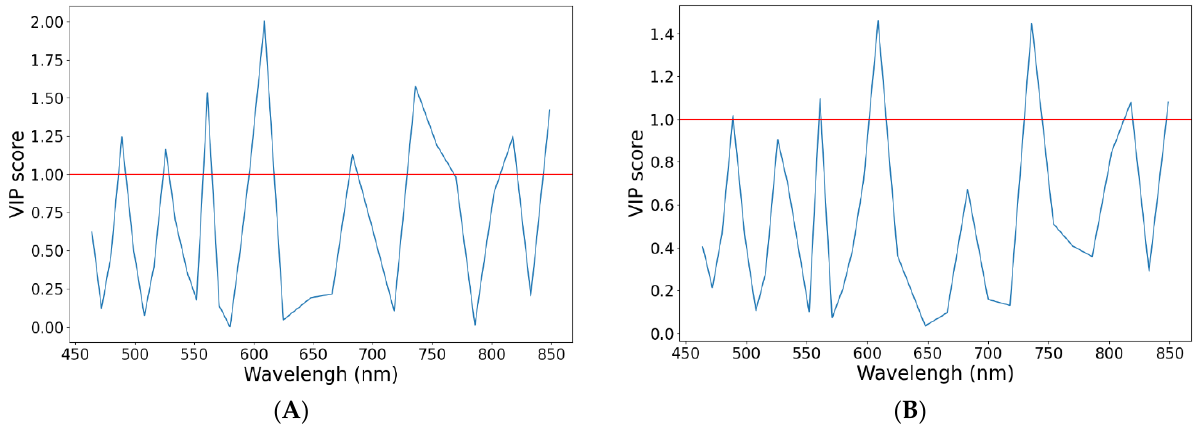
Figure 6. VIP scores for ( A ) SSC and ( B ) MC, calculated by PLS.